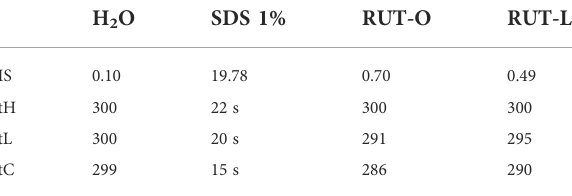
TABLE 1 Irritation score (IS) values for positive control (SDS 1%), negative control (distilled water), RUT-O, and RUT-L. tH = time of hemorrage; tL = time of lysis; tC = time of